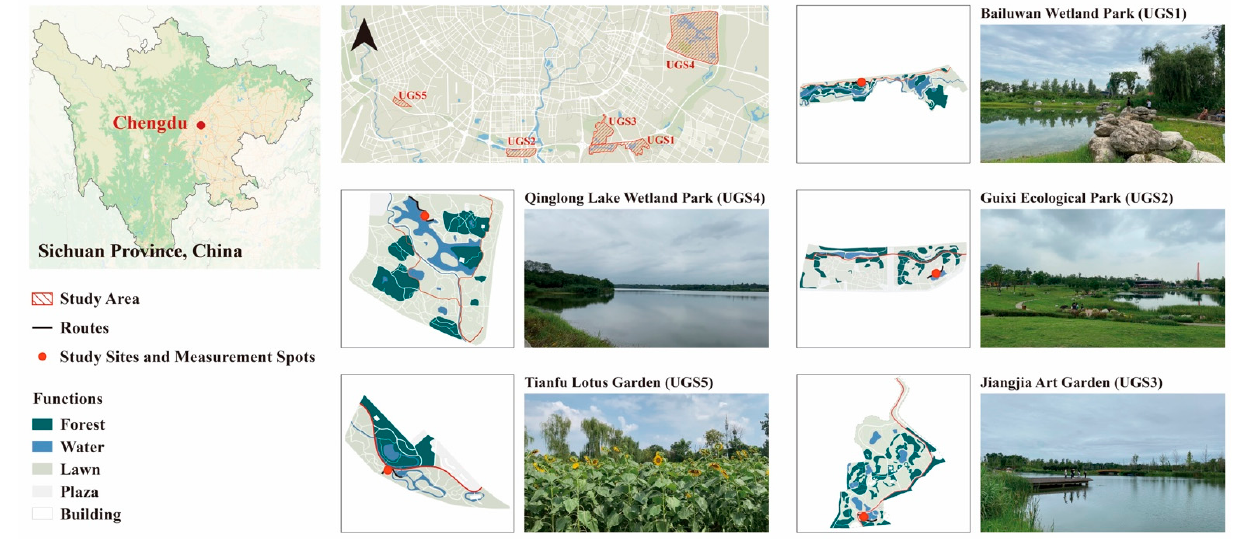
Figure 1. Site photos of measurement spots. Table 1. General conditions of the selected study sites and measurement spots.